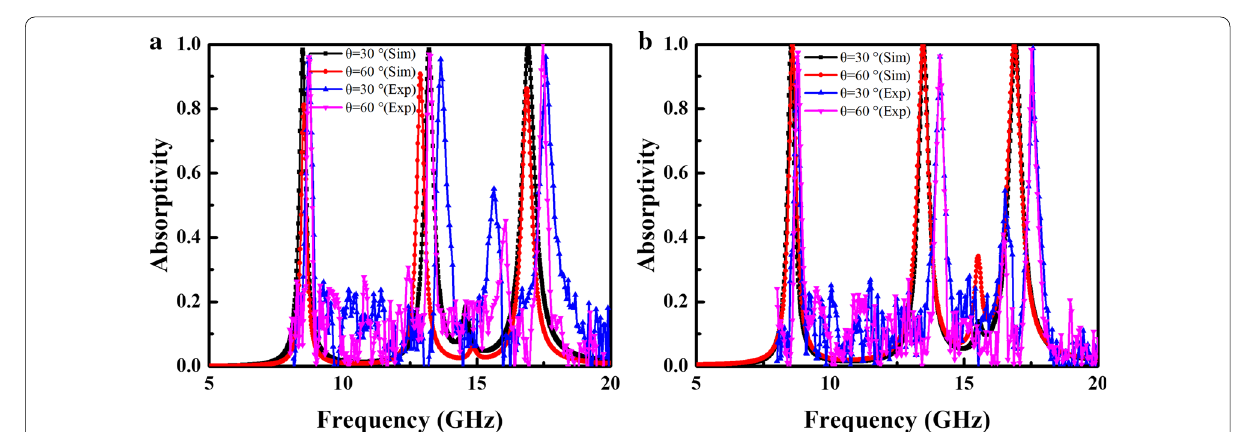
Fig. 10 Simulated and measured absorption for different incident angles: a TE and b TM